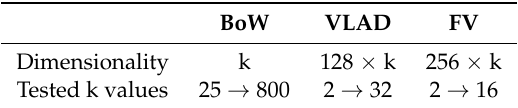
Table 2. Dimensionality of encoded image features and range of k parameter tested in the experiments (k = Number of words/clusters/Gaussian models in the SIFT descriptor space).